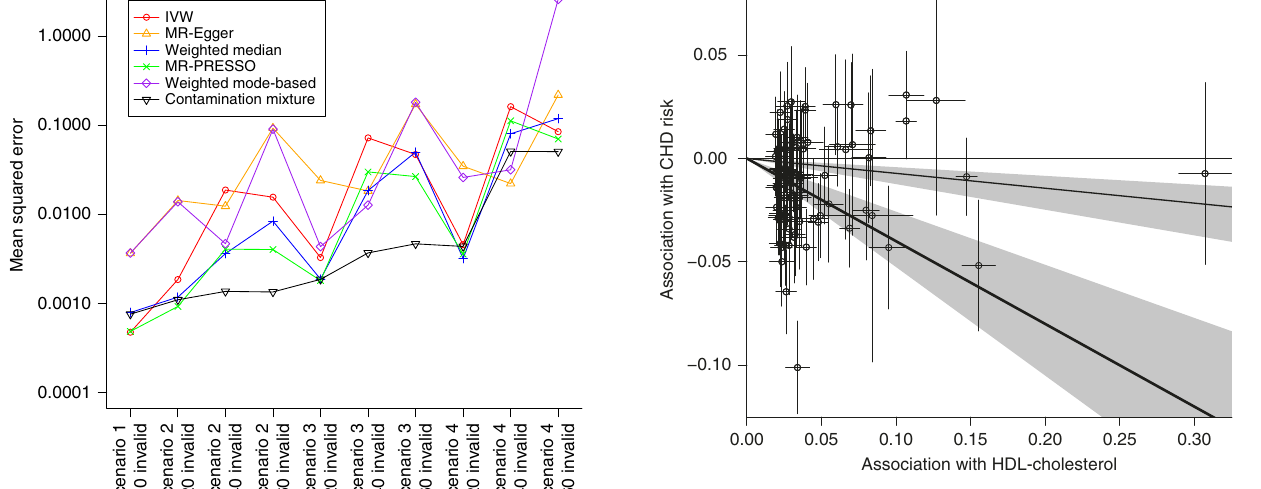
Table 4): mean corpuscular haemoglobin concentration, and red